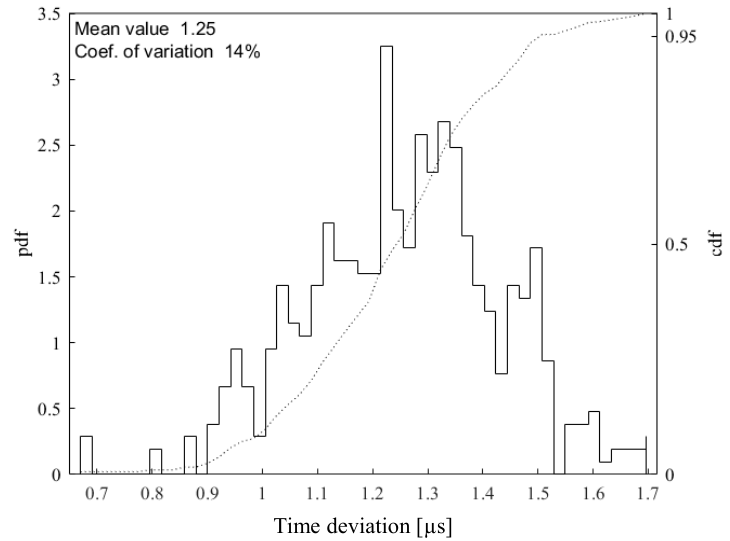
Figure 8. Measured synchronization accuracy. 277